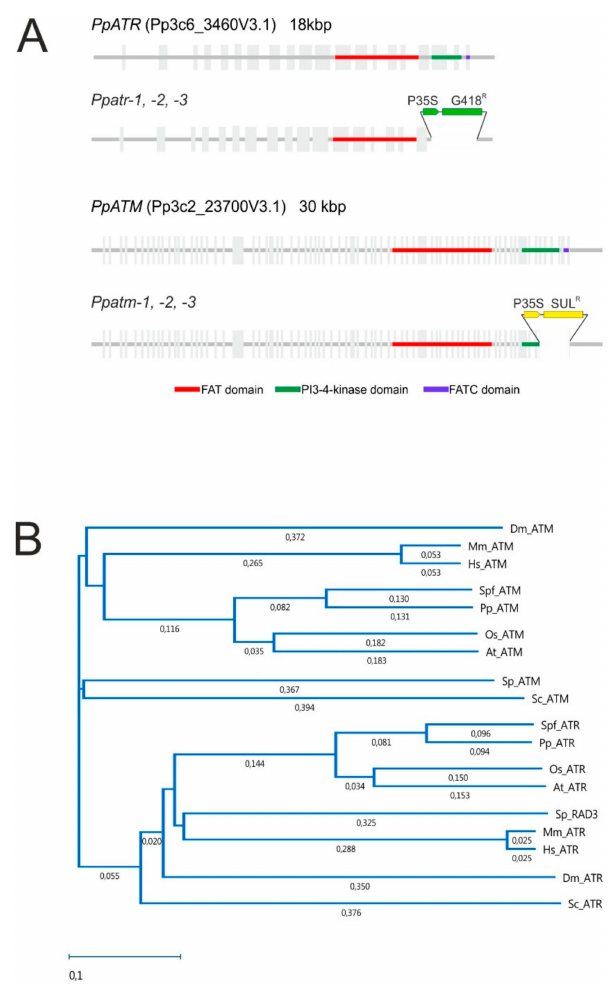
Figure 1. Phylogenetic analysis, gene structure, and targeted replacements. ( A ) The structure of PpATM and PpATR genes is shown with exons indicated in light gray and the conserved FAT, PI3-4 kinase, and FAT-C domains in color. The domain replacements obtained by gene targeting are shown